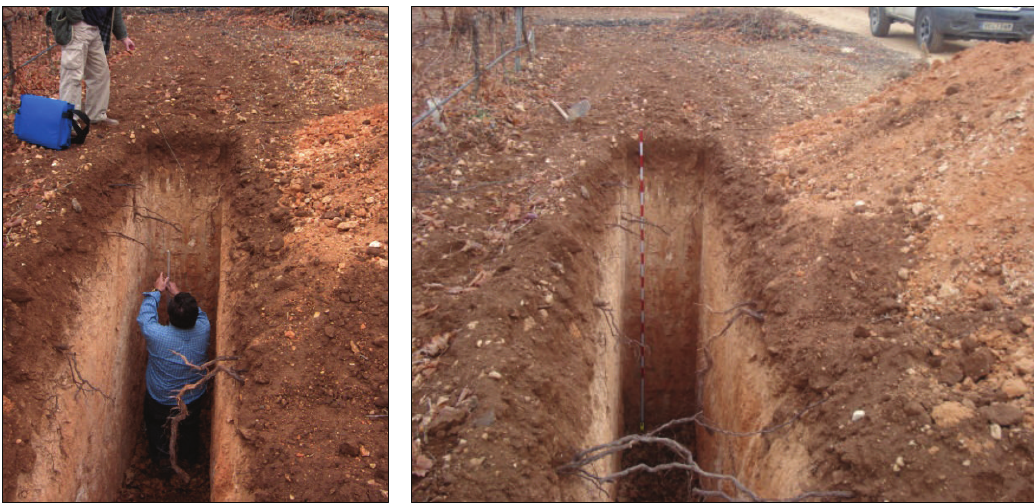
Figure 2: Sampling process in